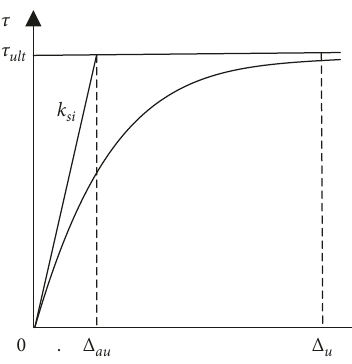
Figure 3: Shear stress-shear displacement curve at the pile-soil